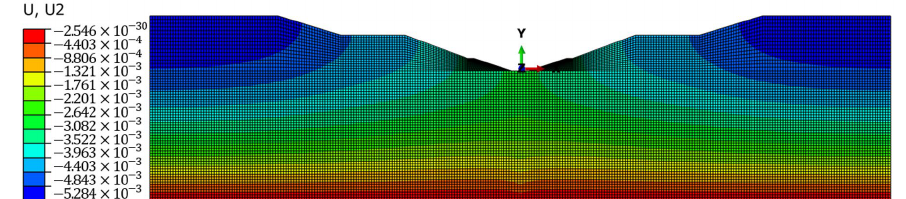
Figure 16. Canal settlement nephogram when t = 20 years.